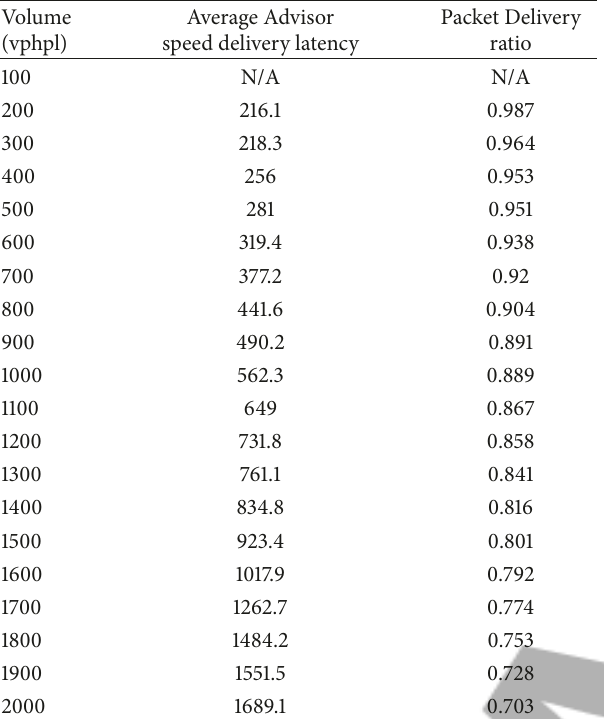
Table 7: Average advisory speed limit delivery latency of IASLD in different traffic